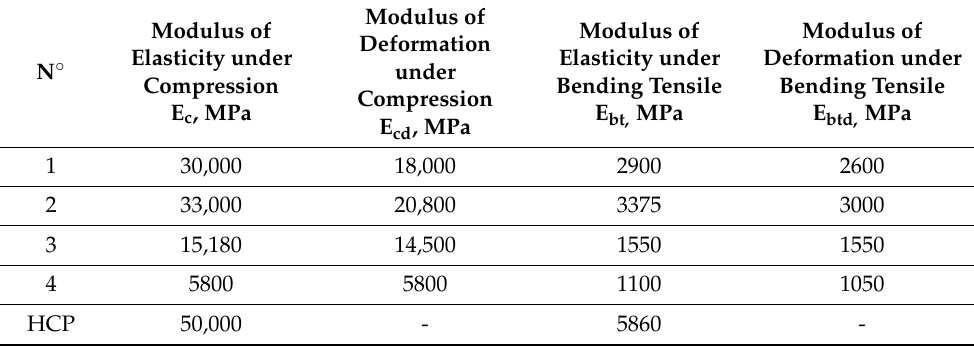
Table 1. Deformative properties of